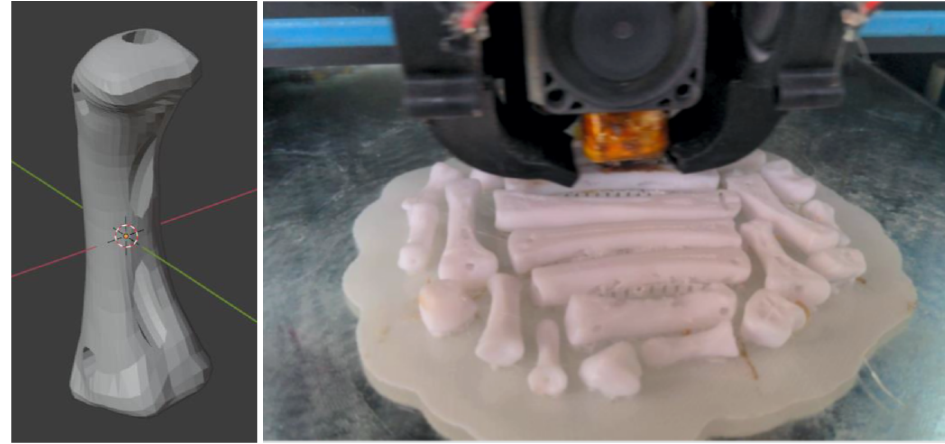
Figure 6. Metacarpal bone CAD model and 3D printing process of hand